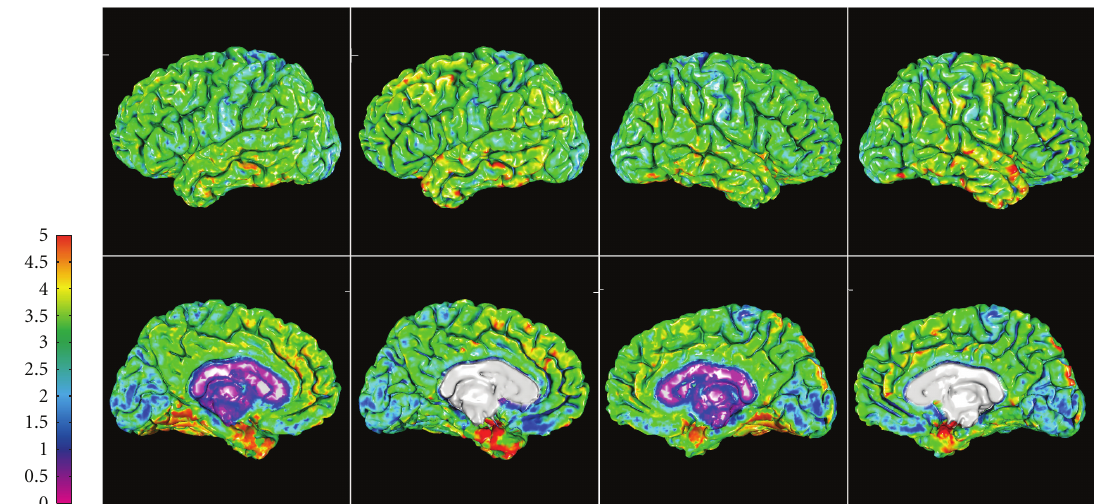
Figure 9: Example of side-by-side comparison of DELFMAP (column 1 and 3) and FreeSurfer (column 2 and 4) thickness maps (OAS1 202 1, on pial surfaces, left/right hemisphere in the left/right two columns, resp.; 1st row: lateral surface; 2nd row: medial surface; colorbar range 0–5